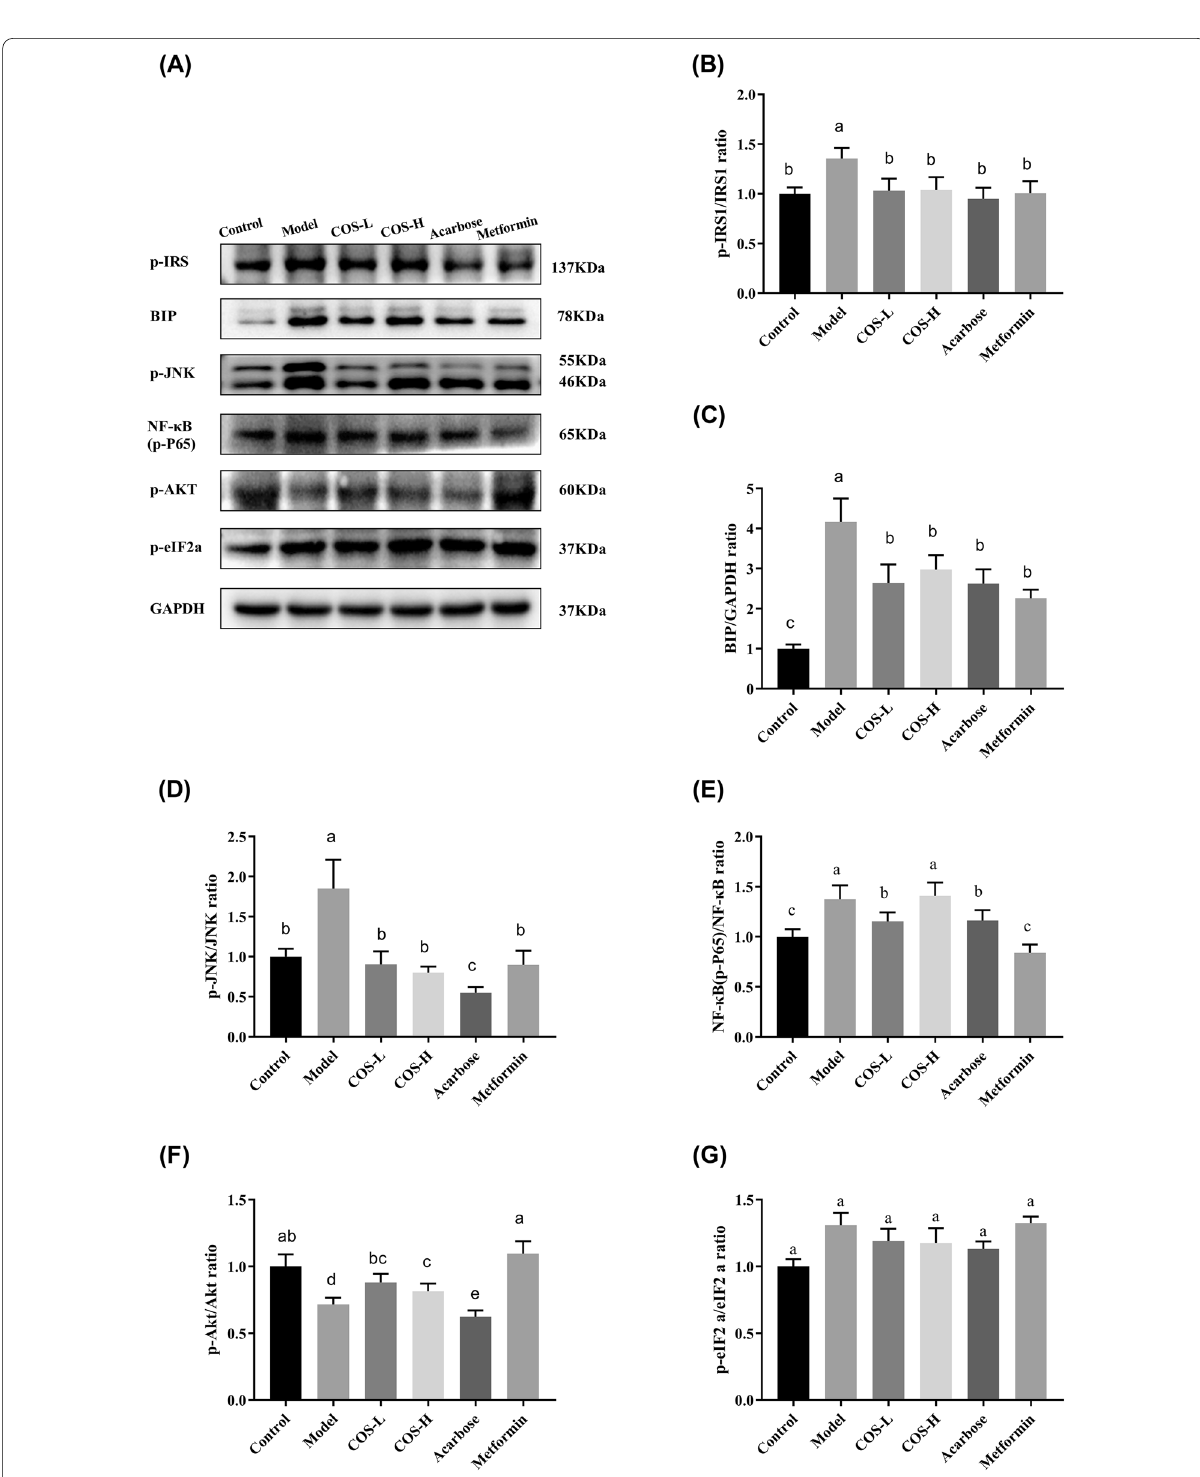
Fig. 11 The expression of proteins related to the insulin signaling pathway in the mouse muscles. A Western blot images, B P-IRS-1 (Ser307)/ GAPDH, C BIP/GAPDH, D p-JNK (Thr183 Tyr185)/GAPDH, E NF-κB (P-p65) (Ser536)/GAPDH, F p-Akt (Ser473)/GAPDH, G p-eIF2A (Ser52)/GAPDH. + Normalization versus GAPDH ensured equal protein